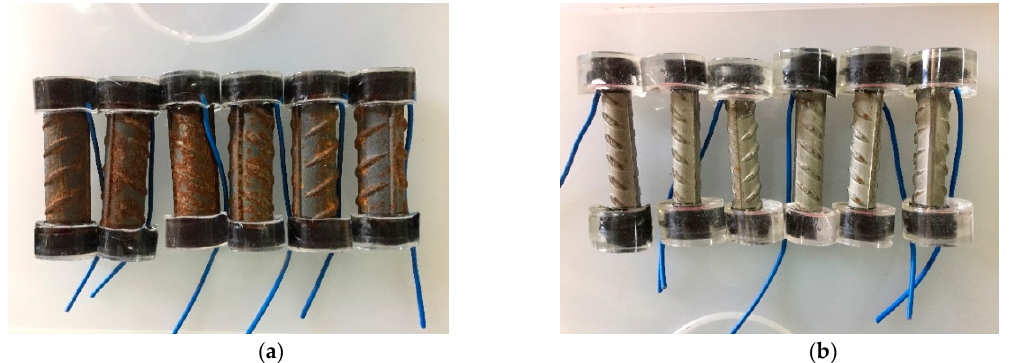
Figure 2. Specimens: ( a ) HRB500; ( b ) novel type-2205 duplex stainless steel.